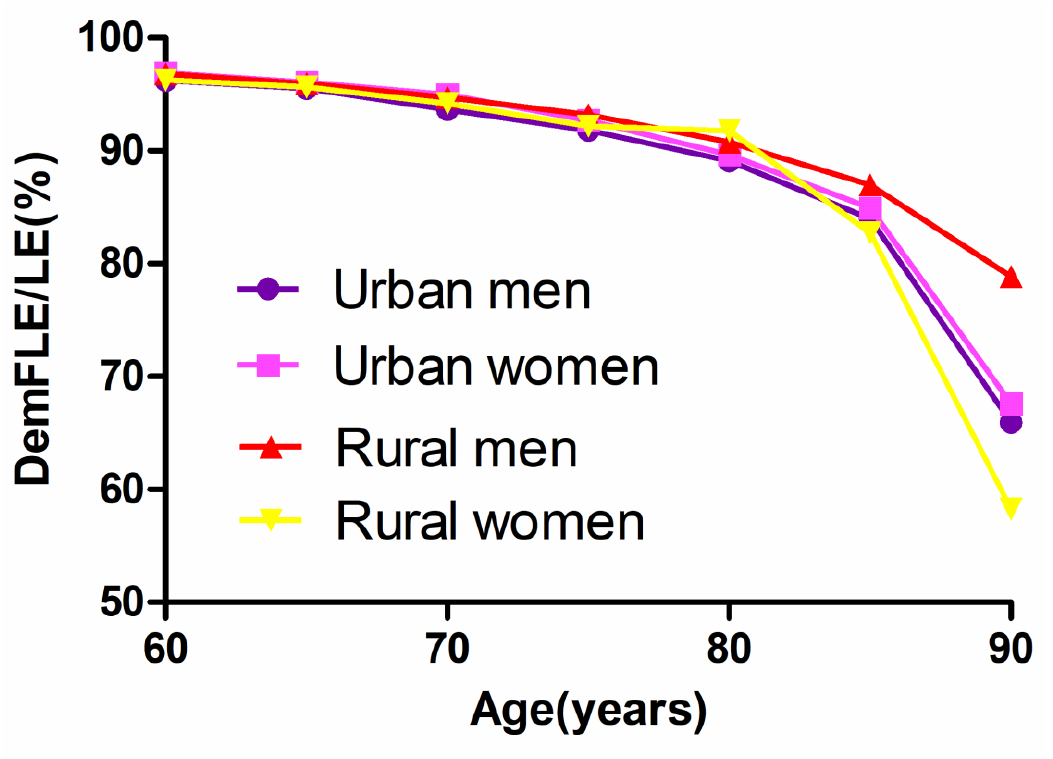
Figure 3. Trends of dementia-free life expectancy as a proportion of life expectancy (DemFLE / LE) for men and women in urban and rural areas.